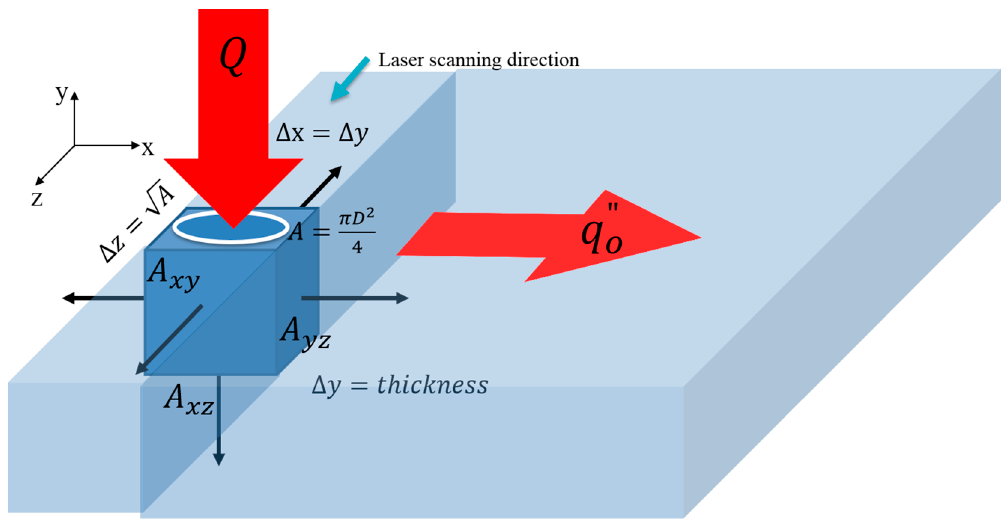
Figure 8. One-dimensional semi-infinite conduction model.